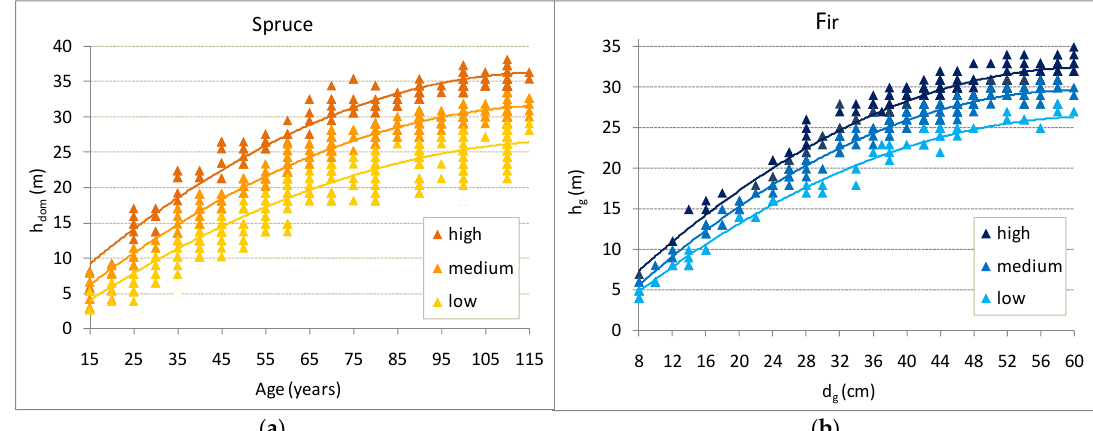
Figure 3. Relationship between dominant height ( h dom ) and age in spruce ( a ) and between average height and average diameter ( d g ) in fir ( b ).